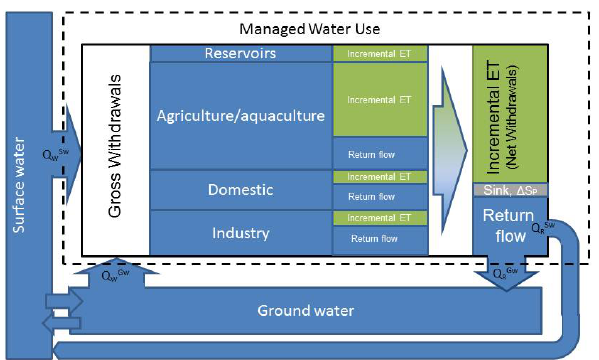
Fig. 5. Schematic presentation of withdrawal